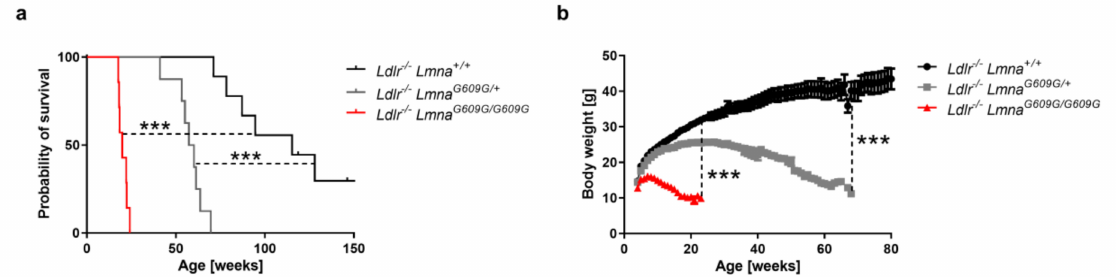
Figure 1. Shortened survival and reduced body weight in male Ldlr − / − Lmna G609G / G609G and Ldlr − / − Lmna G609G /+ mice. ( a ) Kaplan–Meier survival curves of Ldlr − / − Lmna +/+ mice ( n = 9),